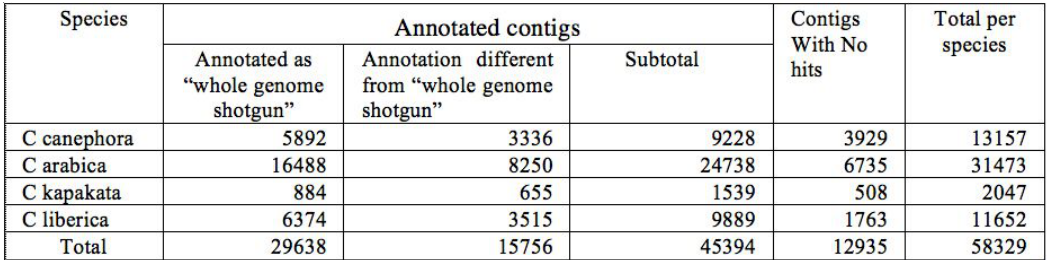
Table 1: Annotated